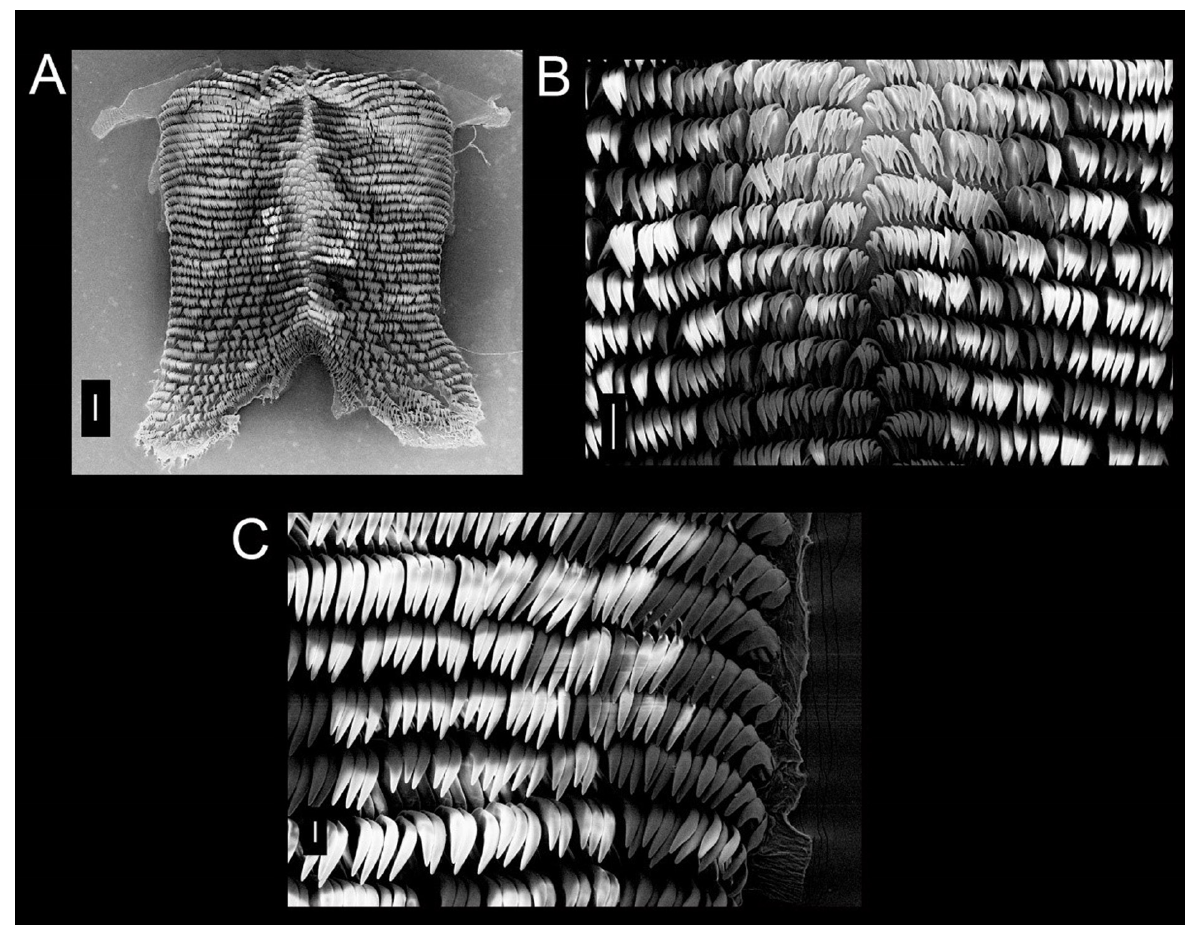
Figure 6. SEM of radula of Platydoris angustipes . A panoramic view B central region with rachidian tooth absent C lateral teeth. Scale bars: 300 µm ( A ); 100 µm ( B ); 30 µm ( C